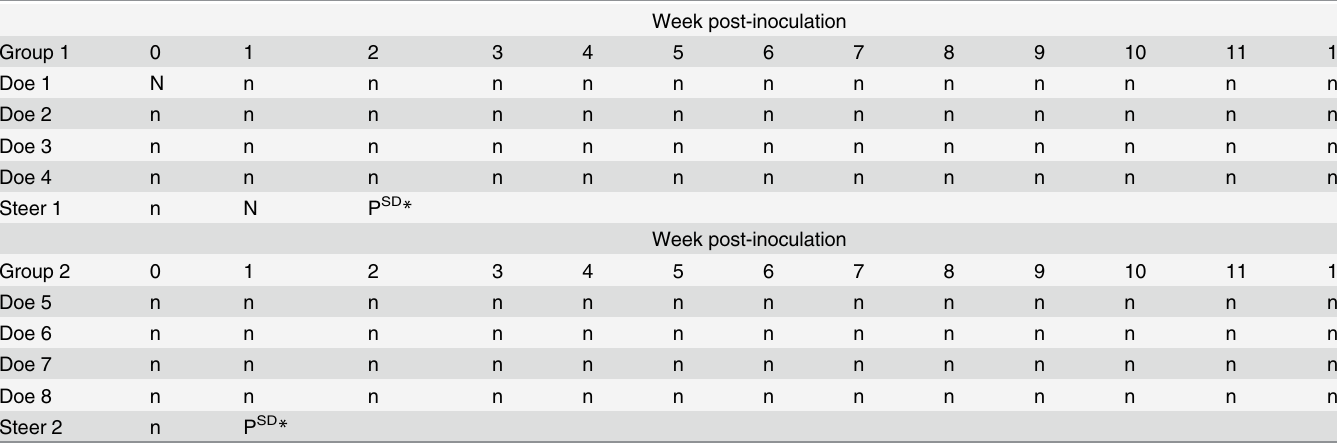
Table 1. Evaluation of the white-tailed deer challenged with Babesia bovis .